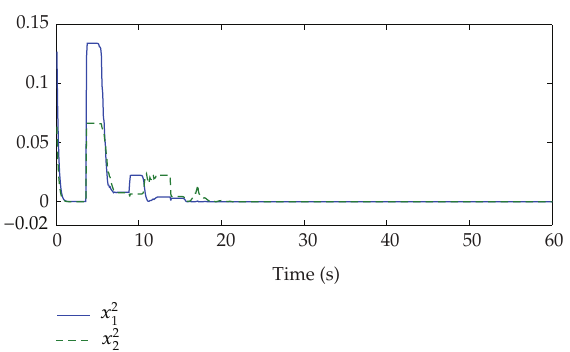
Figure 1: Mean-square exponential stability of the neutral stochastic system with interval time-varying delay.